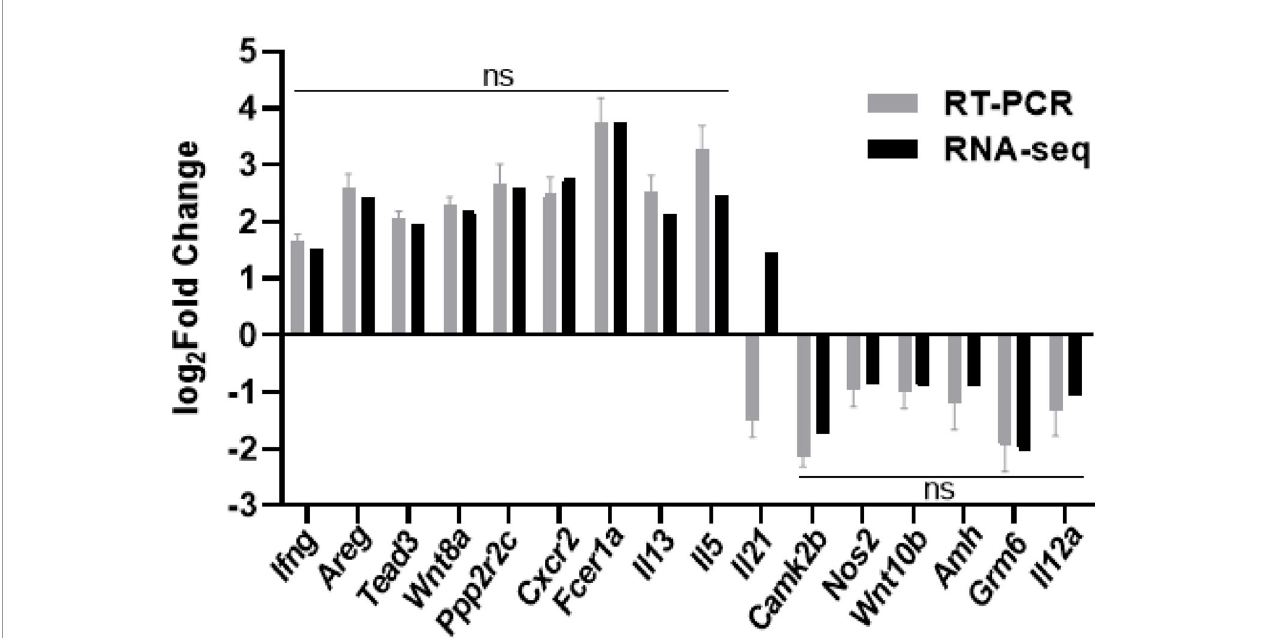
FIGURE 7 | qRT-PCR validation of select differentially expressed genes by RNA-seq. Sixteen individual genes involved in signal transduction and metabolism were analyzed by qRT-PCR. The log 2 Fold Change determined from the relative Ct values of sixteen genes were compared to those detected by RNA-seq method. The black bar represents the expression levels analyzed by RNA-seq, and the grey bar represents the expression levels validated by qRT-PCR. Replicates ( n= 3) of each sample were run and all the Ct values were normalized to b -actin. Data were analyzed by Mann-Whitney test and shown as the means ± SD. ns, no signi fi